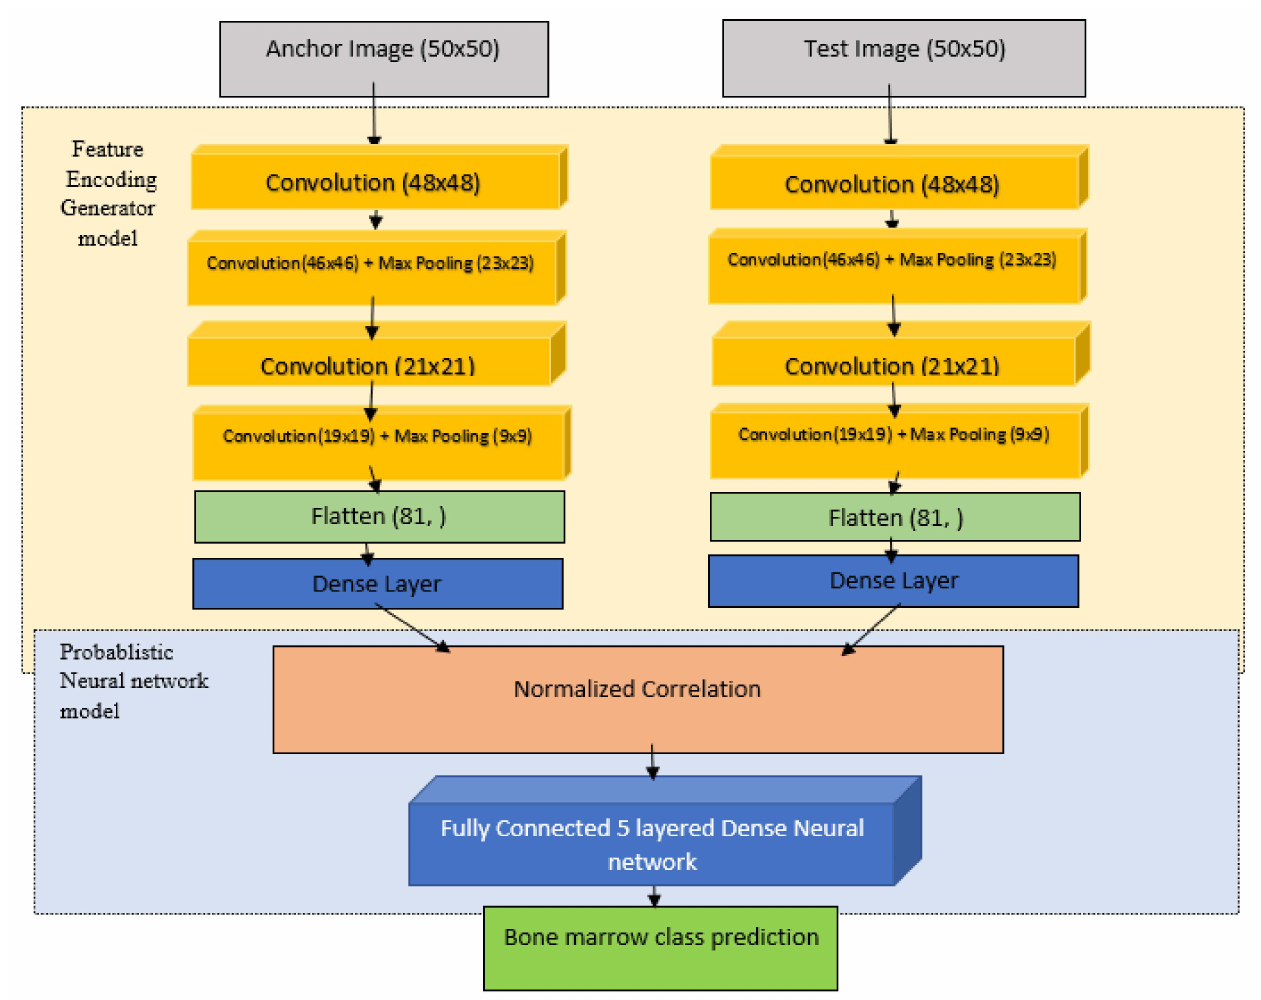
Figure 3. Block diagram of proposed Siamese neural network